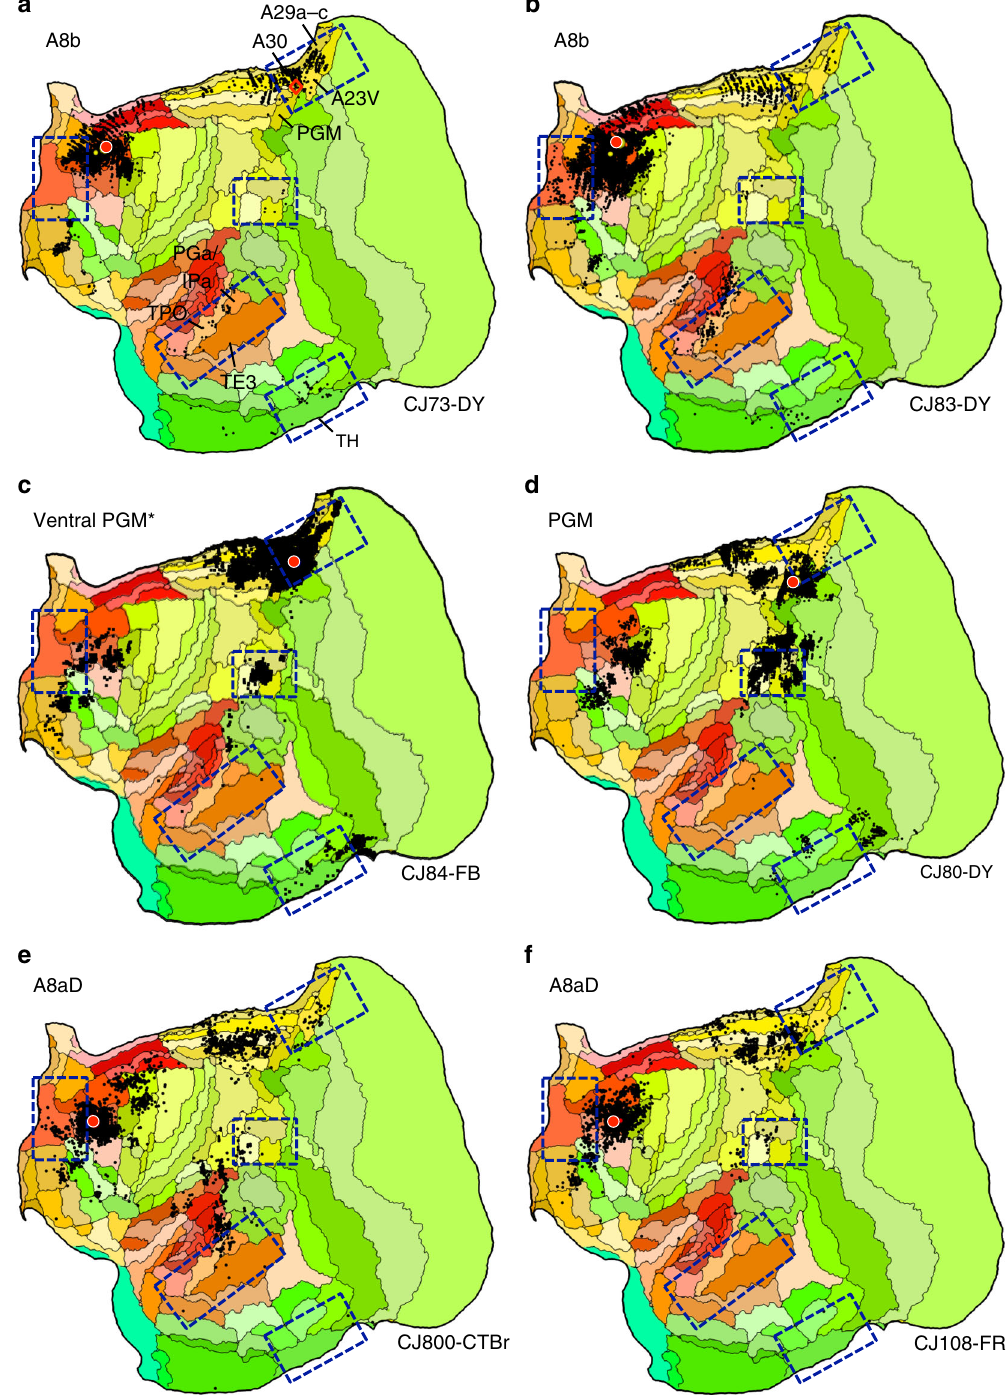
Fig. 5 Additional areas may be components or subdivisions of the apex transmodal network. The human default network contains regions outside of the fi ve-targeted zones, including additional prefrontal regions and potentially more extensive areas along the posterior midline. Injections to two relevant frontal areas are shown, A8b ( a , b ) and A8aD ( e , f ). The two prefrontal areas are displayed alongside posterior PGM ( c , d ). A8b receives projections